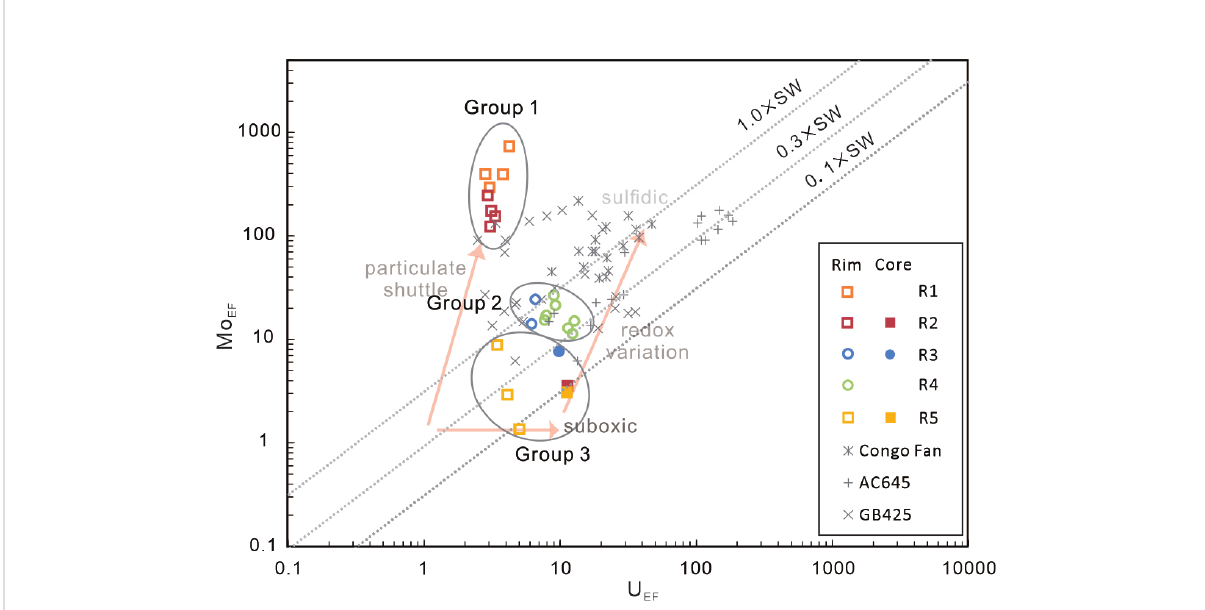
FIGURE 5 Plots of Mo EF vs. U EF for the studied authigenic carbonates (modi fi ed from Hu et al., 2014). The results of the arti fi cially divided groups in this study were circled in gray. Enrichment factors of Mo and U are calculated by being normalized to the post-Archean Australian shale (PAAS) composition (Taylor and McLennan,